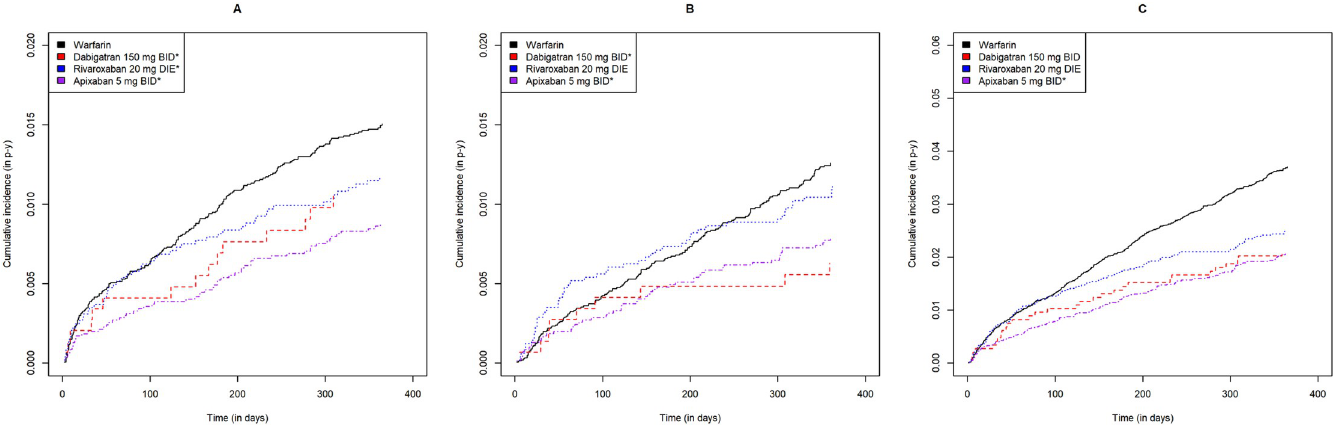
Fig 3. Gastrointestinal, non-gastrointestinal extracranial and all major bleeding cumulative incidence curves for each direct oral anticoagulant at high dose relative to warfarin. Warfarin, dabigatran, rivaroxaban and apixaban are shown in black, red, blue and purple, respectively. Gastrointestinal, non-gastrointestinal and all major bleeding are shown from left to right. � statistically significant difference relative to warfarin (p <